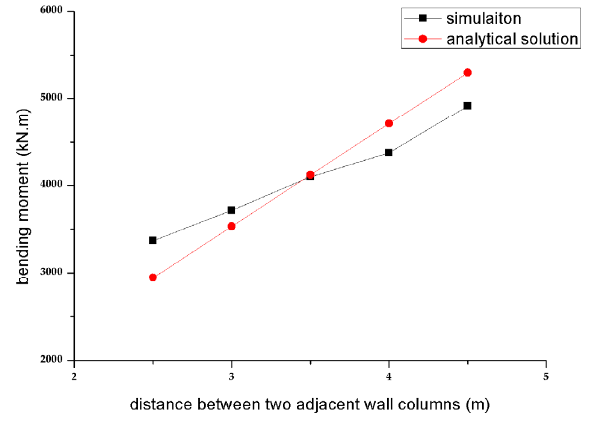
Figure 17. Relation curve of the column bottom bending moment with the distance between the wall columns.